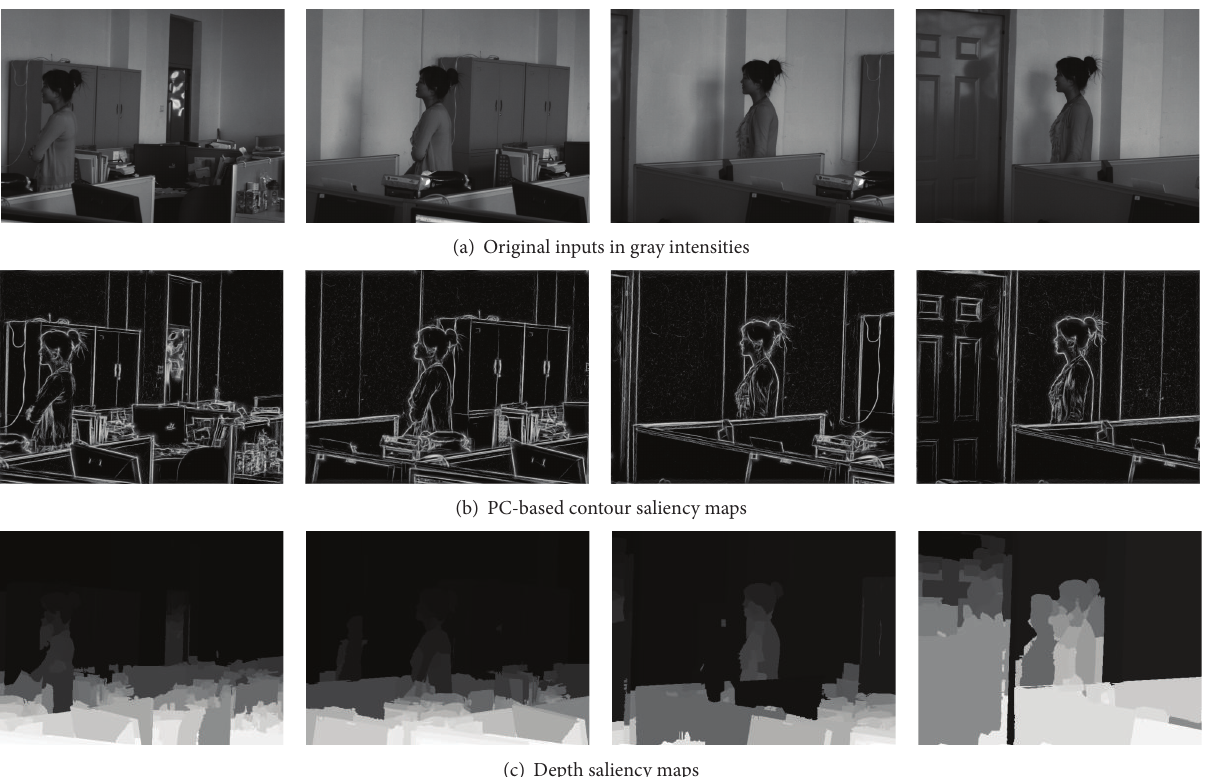
Figure 5: Multiple visual stimuli of dynamic scene 1.